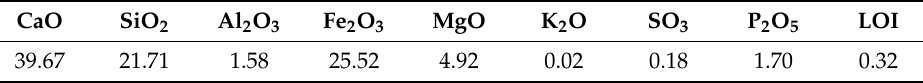
Table 1. Chemical compositions of converter steel slag